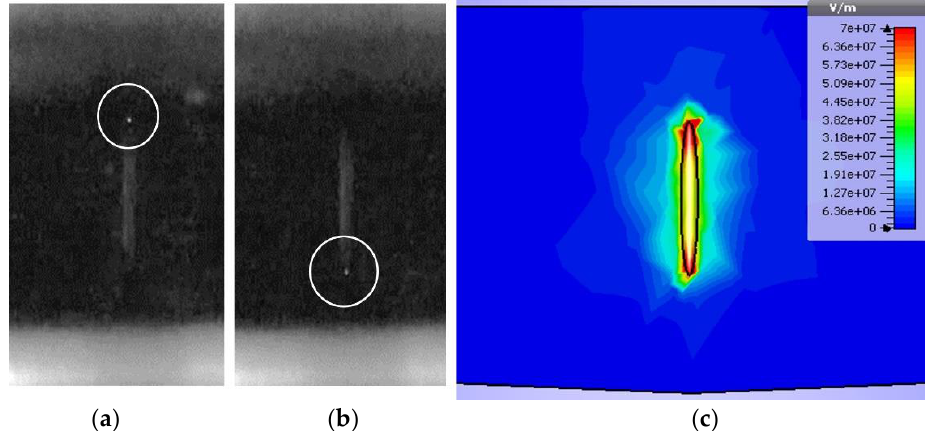
Figure 11. Corona for 8 mm of particle size and d = 2 mm at voltage stress of 75.6 kV: ( a ) corona at the top of particle; ( b ) corona at the bottom of particle; and ( c ) simulation result of E -field distribution.